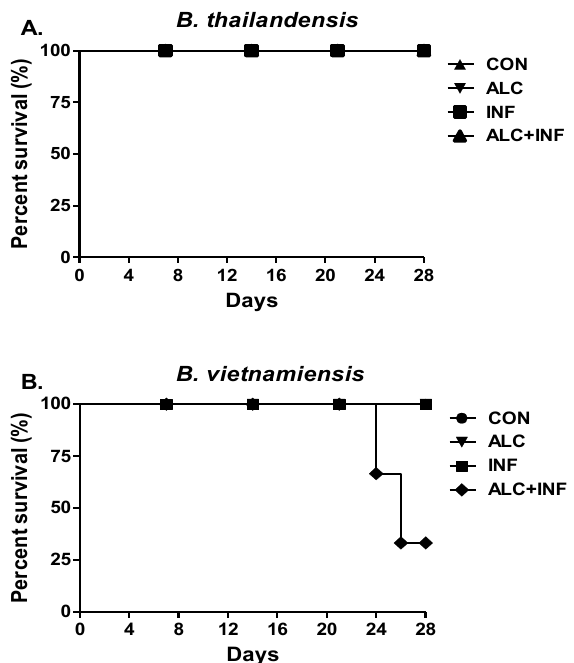
Figure 1. The e ff ects of binge alcohol intoxication on mice survival during B. pseudomallei near-neighbor infections. ( A ) Percent survival of mice after B. thailandensis and ( B ) B. vietnamiensis infection. Mice were injected intraperitonially with 20% v / v of alcohol 30 min prior to intranasal infection with 1 × 10 5 CFU for both bacterial strains. Survival was monitored for 28 days. Control group (CON) was not administered alcohol or infected.